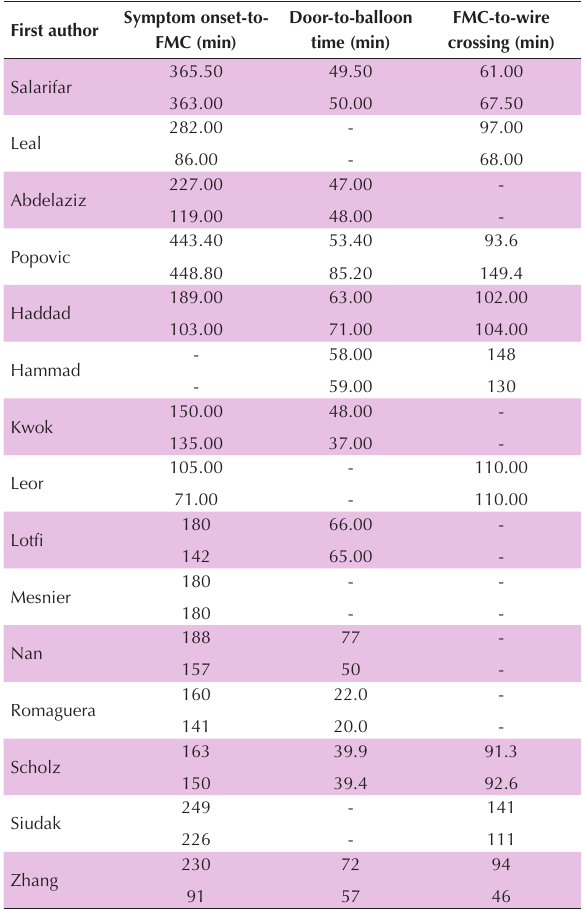
Table 2. The time intervals from symptom onset to wire crossing Symptom onset-to- First author FMC